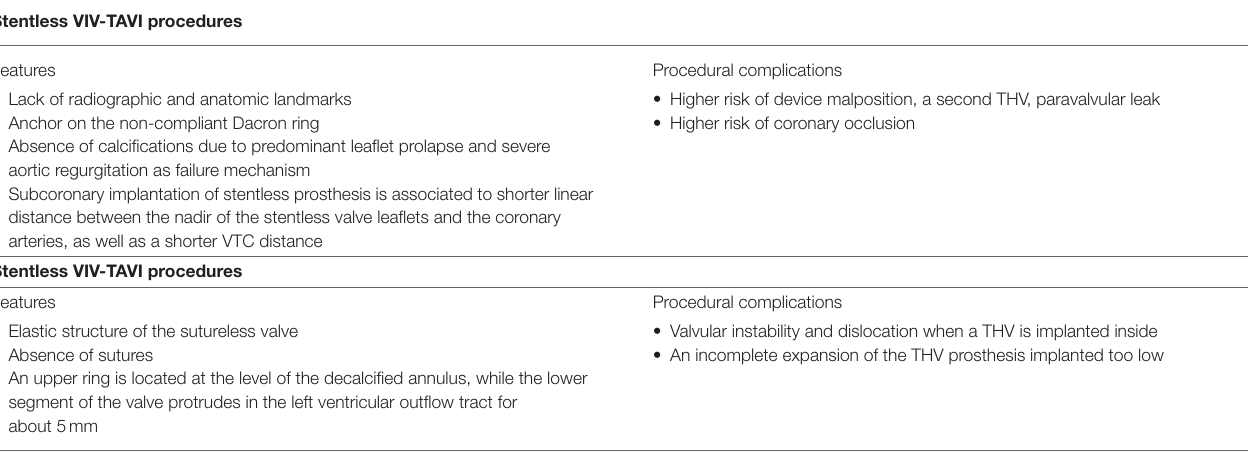
TABLE 2 | Main challenges of stentless and sutureless VIV-TAVI